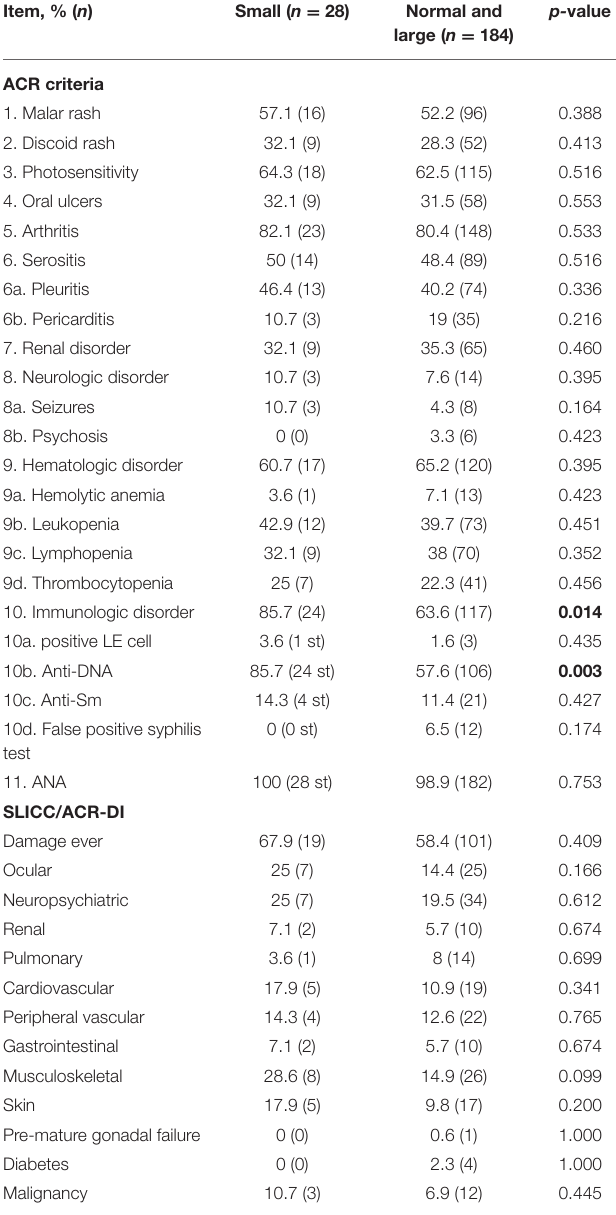
TABLE 4 | Analyses of categorized MPV-values with disease phenotypes defined as fulfilled ACR classification criteria and organ damage. Item, % ( n ) Small ( n = 28) Normal and